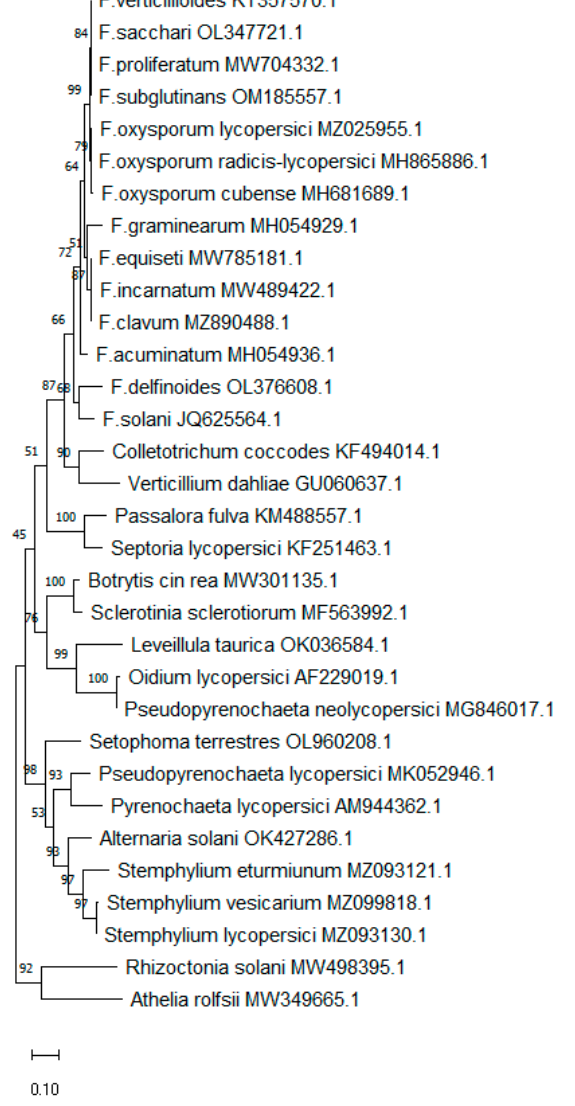
Figure 2. Phylogenetic tree of a partial sequence of the ribosomal internal transcribed spacer (ITS1–ITS2) region of nuclear rDNA by Maximum Likelihood of Fusarium spp. and other fungal species that affect tomato plants with respective GenBank accession numbers.